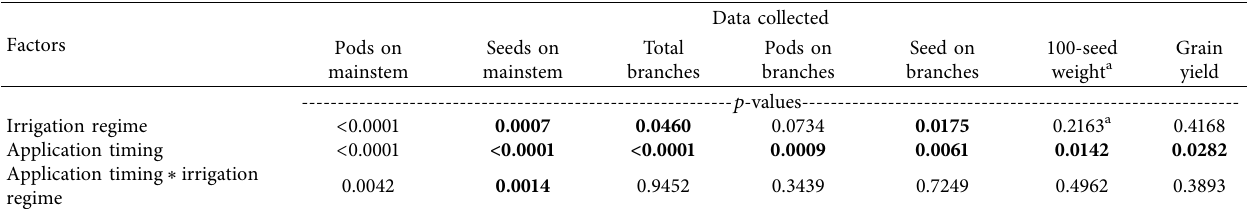
Table 2: Effects of dicamba, irrigation regime, and application timing and the interaction of these effects on yield components and grain yield associated with soybean for the irrigation experiments conducted in Fayetteville and near Colt, AR, in 2019. Factors